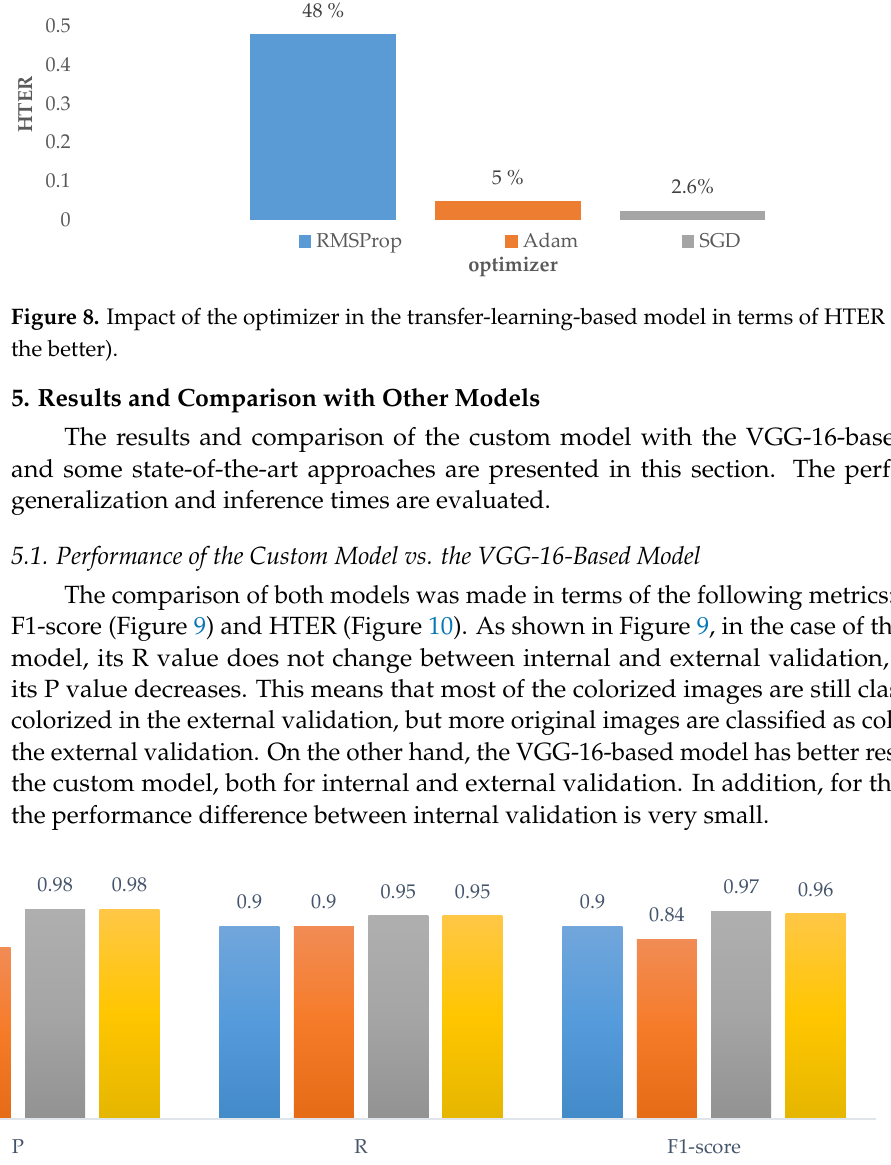
Figure 10. Performance evaluation of the custom model and transfer-learning-based model: HTER (the lower the better).